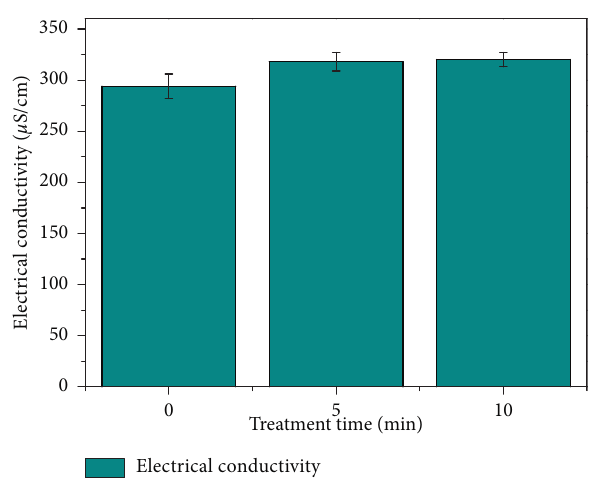
Figure 16: Variation of conductivity with treatment time (5kV, 19.56kHz, and 5L/min).